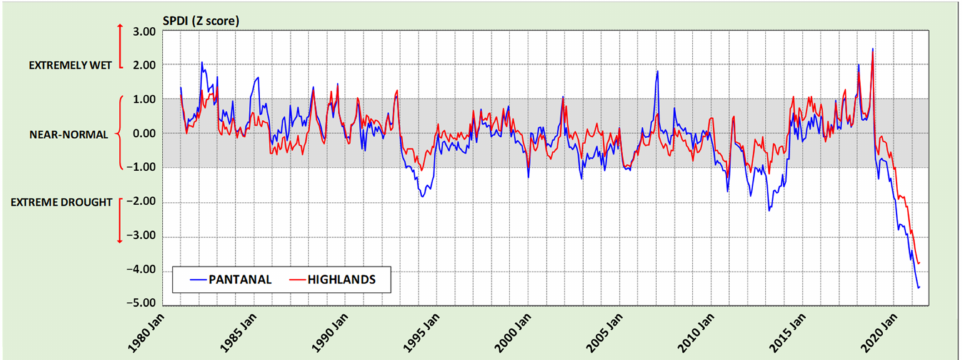
Figure 4. Temporal dynamics of precipitation anomalies for the series January 1981–June 2021 at the Pantanal and the surrounding Highlands. Precipitation anomalies are measured as Standardized Precipitation Drought Index (SPDI) and interpreted using SPI classification system from McKee et al. [34] and WMO [37] (see Table 2). The grey area represents the near-normal condition (i.e., − 1.0 ≤ SPDI <